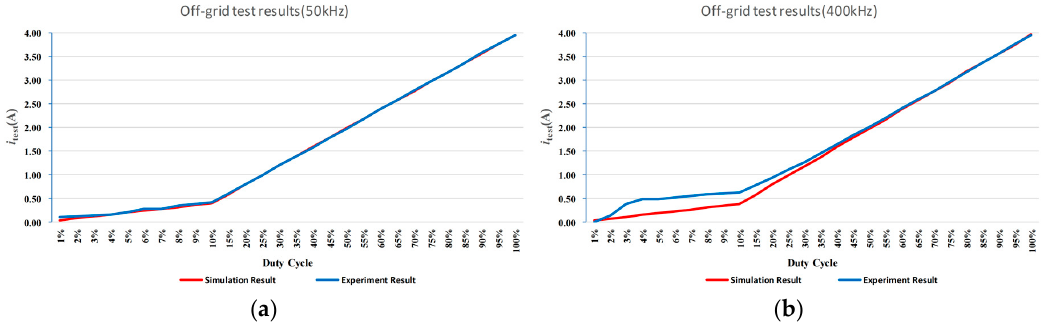
Figure 12. The output current responds between simulation and experiment at different frequencies: ( a ) 50 kHz; and ( b ) 400 kHz.